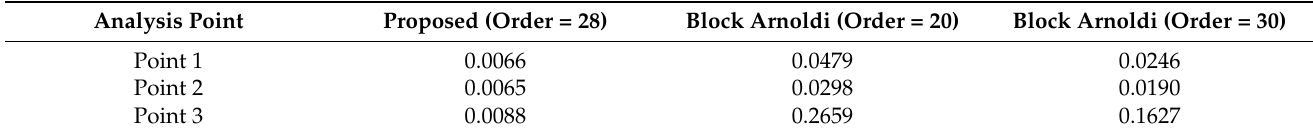
Table 3. Comparisons of relative errors on different observing points by using the proposed and conventional